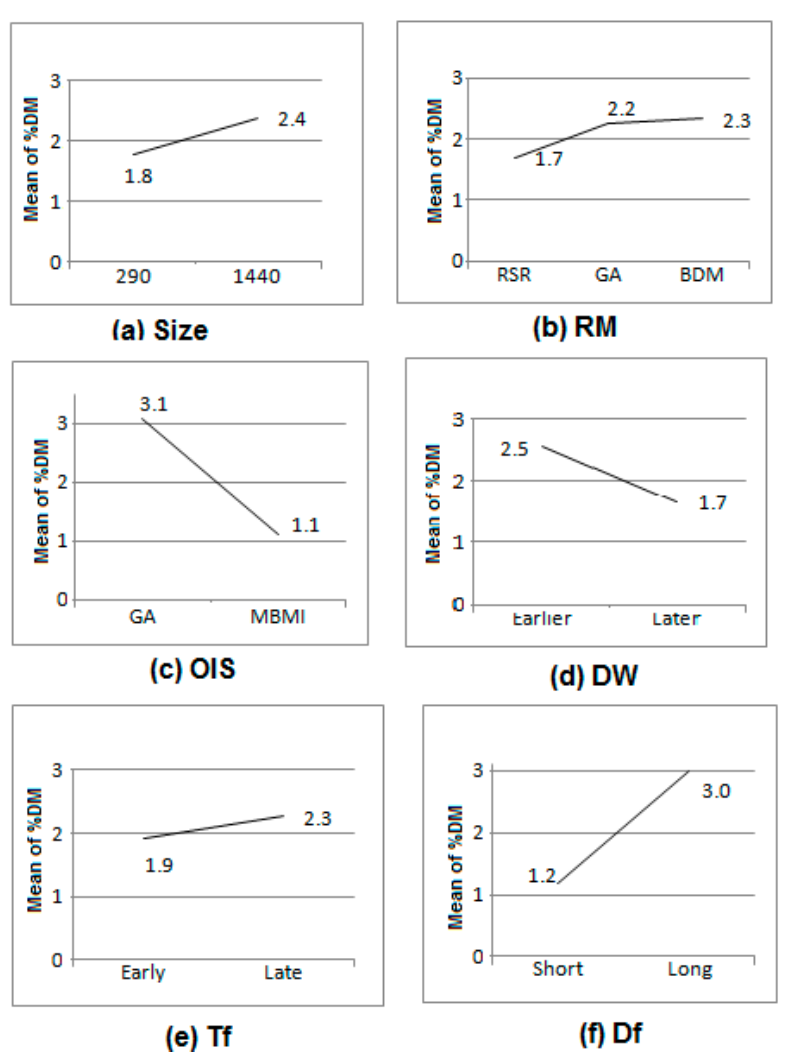
Figure 7. E ff ect of the levels of factors on the mean percent deviation of the make-span. Figure 7. Effect of the levels of factors on the mean percent deviation of the make-span. The mean percent deviation of the make-span is lower in the case of smaller-sized problems and increases with greater problem size, which is expected. Disruptions that occur at earlier workstations affect the mean percent deviation of the make-span more than those that occur later. An earlier disruption affects the entire schedule, thereby increasing the mean percent deviation of the make-span. The duration of failure at that particular workstation affects the percent deviation of the make-span to a greater extent, which is highly expected. Though the genetic algorithm is preferred over the bottleneck minimum idleness in scheduling problems, the modified bottleneck minimum idleness indicates a lower mean percent deviation of the make-span. Since the genetic algorithm, in itself, has a lesser idle time than the modified bottleneck minimum idleness. Hence, the modified bottleneck minimum idleness can accommodate disruption more than the genetic algorithm. RSR performs better than the other two methods used for rescheduling (refer to Figure 8). In order to study the combined effect of rescheduling methods with different combinations of other factors, interaction effects are evaluated. The interaction effects of combinations